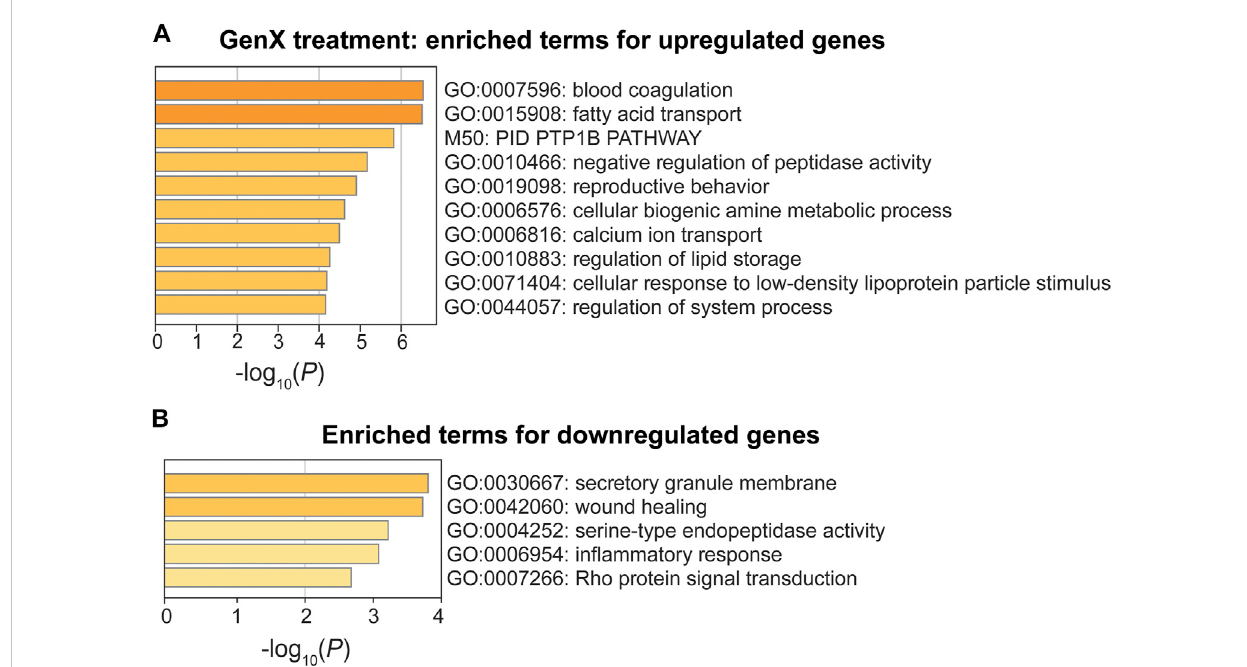
FIGURE 6 Pathwayenrichmentanalysis ofDEGsbetweentheGenXtreatment andcontrolgroups. (A,B) Enriched functionalcategories for upregulated genes and downregulated genes in the GenX treatment group compared to the control group. Enrichment scores are measured by − log 10 ( p